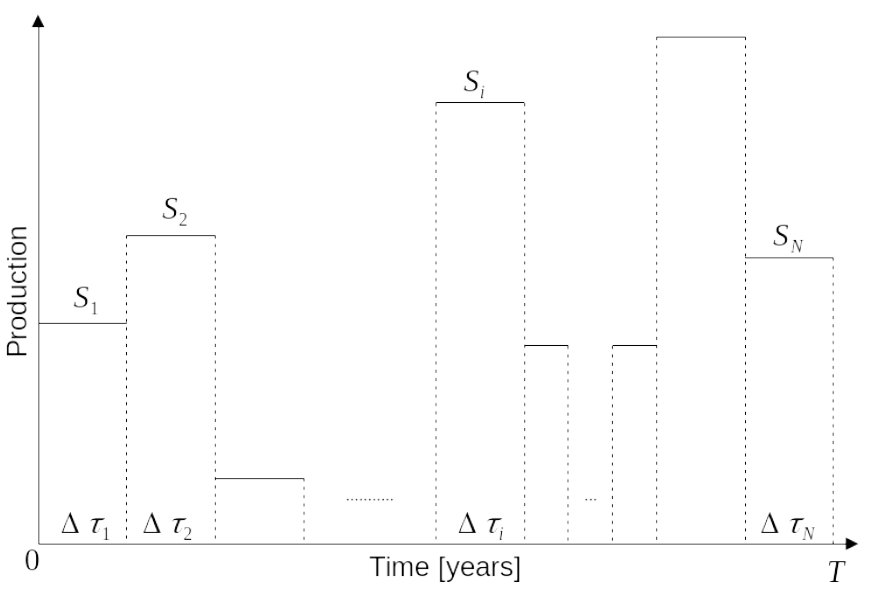
Figure 1. The staircase function of the actual operation course of a renewable energy source (RES) in all T years of its